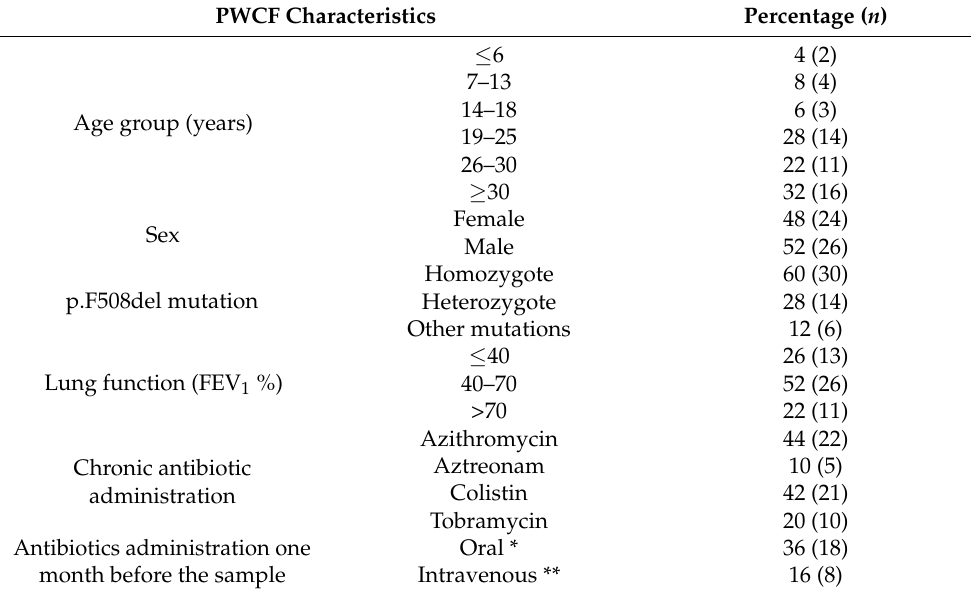
Table 1. Study cohort characteristics: demographic, clinical and biological data. A total of 50 people with cystic fibrosis (PWCF) were